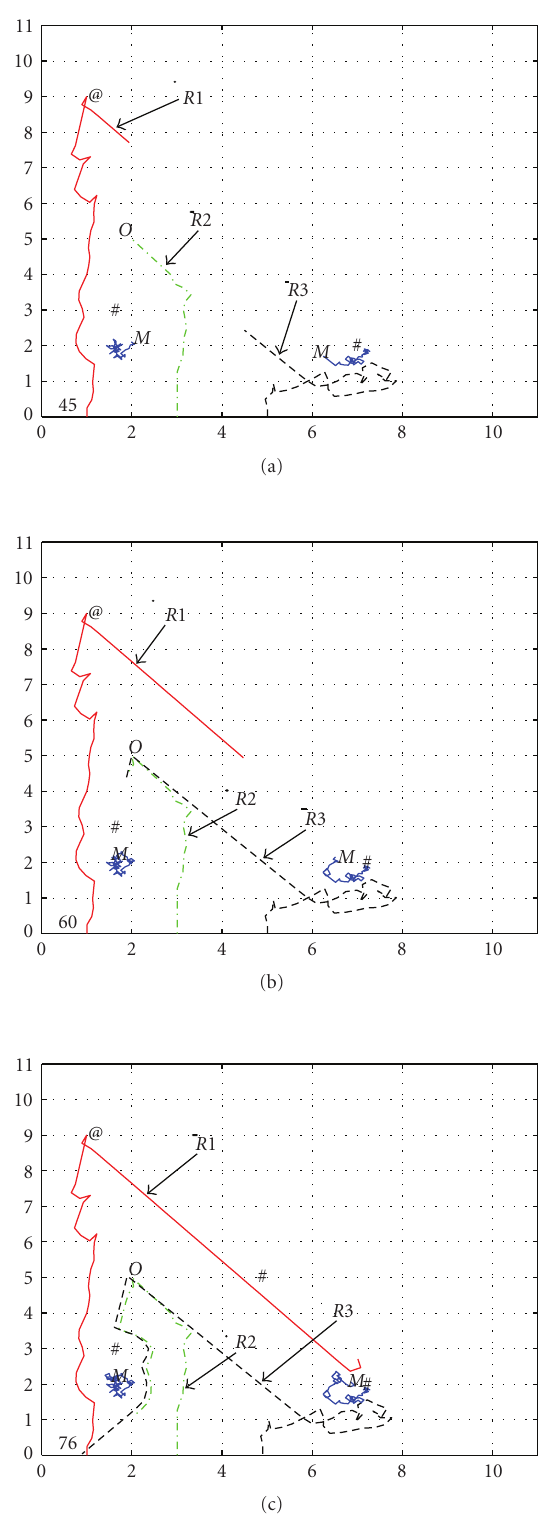
Figure 10: This figure is to show the agent team coordination in a big object carrying task. In (a) R 2 finds a big object, stops searching and calls for help. In (a) R 3 comes to help after receiving the confirm message. In (b) R 3 arrives at the big object and R 2 and R 3 are carrying the big object home together. Finally, in (c) R 2 and R 3 reached the object